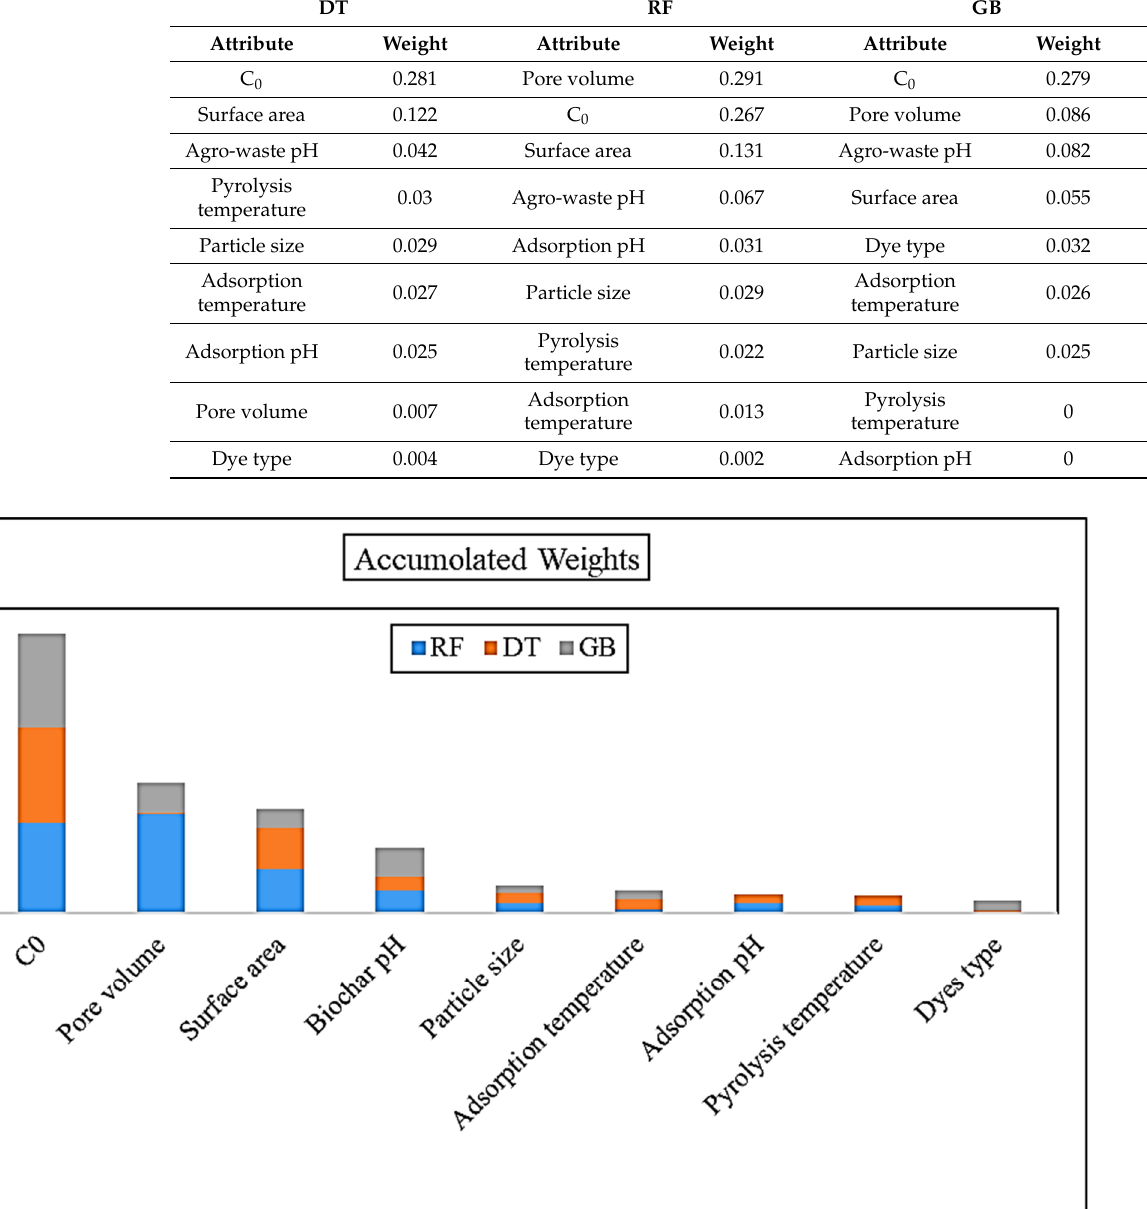
Figure 1. Accumulated weights of variables based on three ML methods.